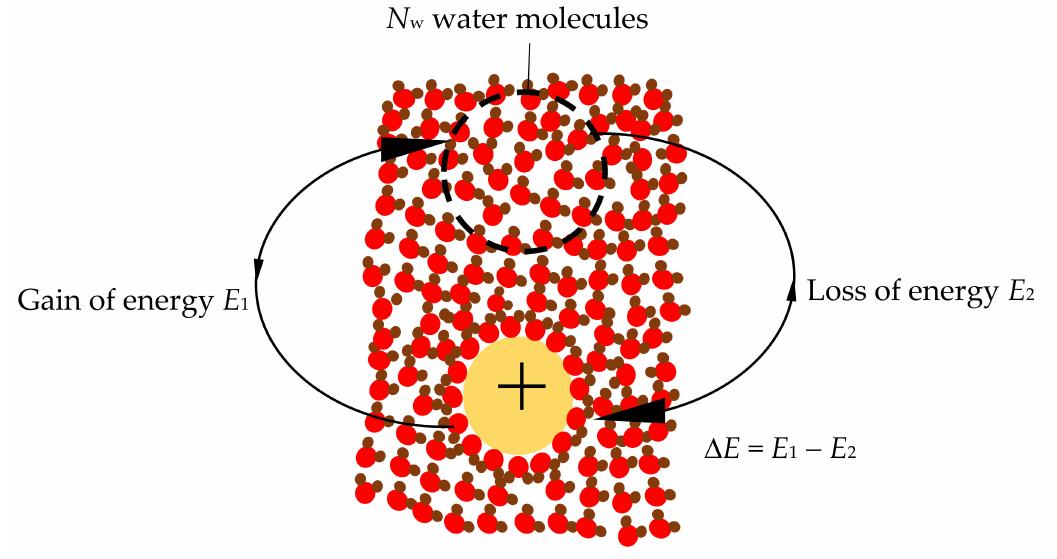
Figure 2. Mechanism of ion adsorption on the air / water interface and its concurrent energetical balance.